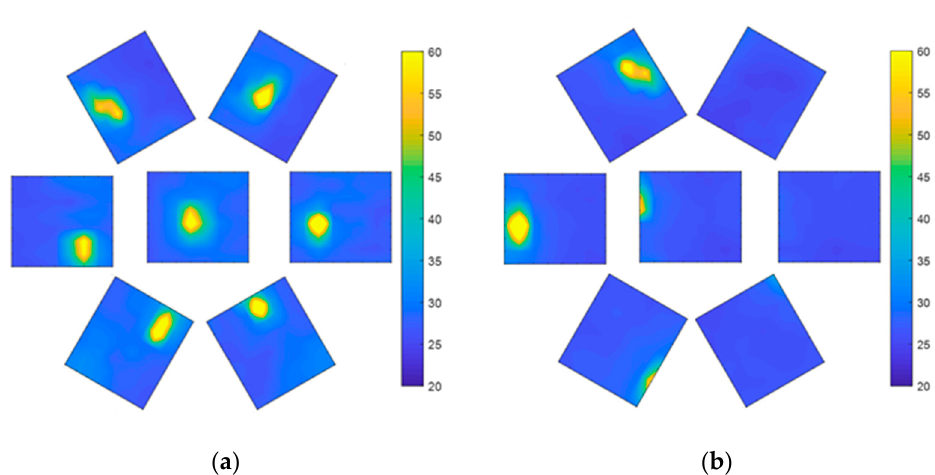
Figure 23. FOV test at 0 Pa; ( a ) Compound eye front test image. ( b ) An image in which the compound eye is rotated to the edge of the FOV.